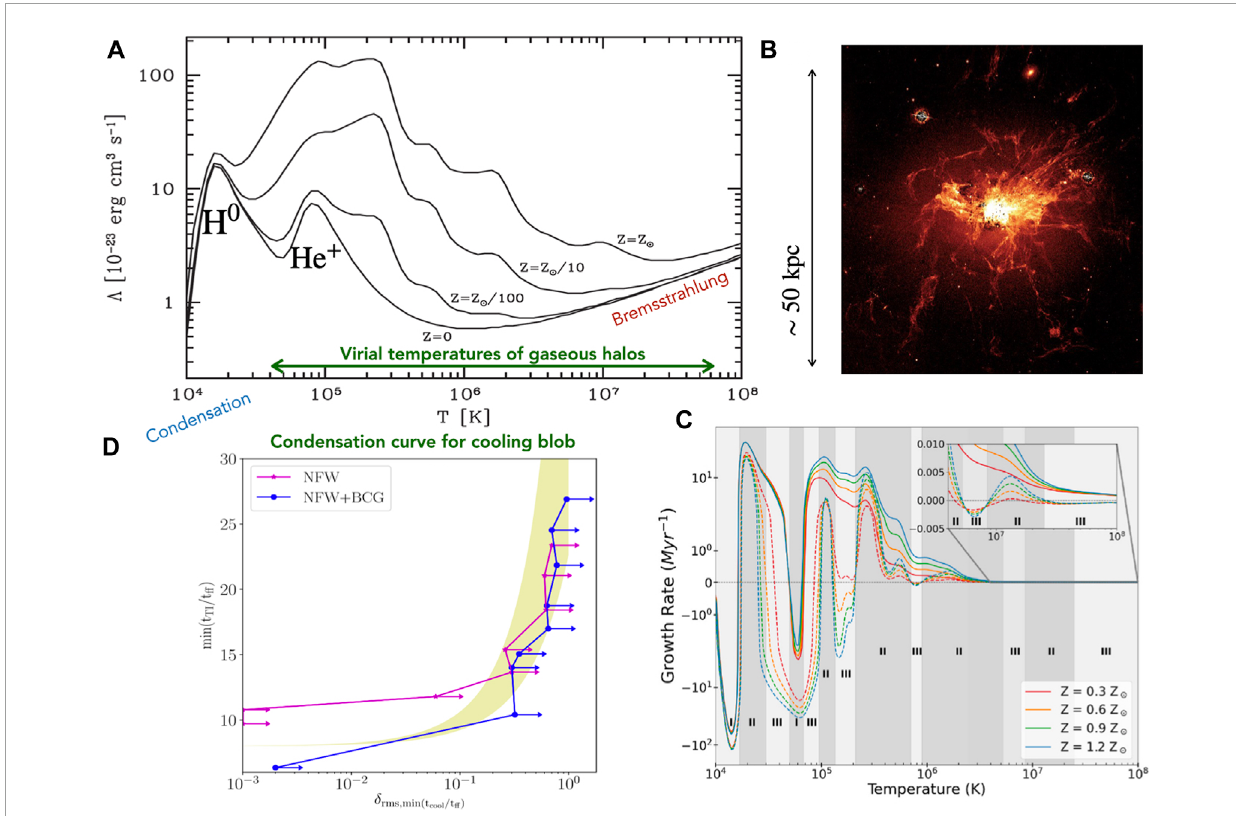
FIGURE 1 (A) Cooling function Λ( T ) as tabulated by Sutherland and Dopita (1993) for a gas in collisional equilibrium. The condensed gas is roughly around 10 4 K. (B) H α emission in red in NGC 1275 in the center of Perseus cluster (Figure 1 in Fabian et al., 2008) showing the filamentary structures, and the typical dimensions are 6 kpc in length and 70 pc in width. (C) Cooling function showing regimes of isobaric and isochoric stability/instability. (I) denotes the regime of stability for either modes, (II) denotes the regime of instability of either modes, and (III) denotes regime of isobaric instability and isochoric stability (see Das et al., 2021). (D) This parametric curve shows how local thermally unstable overdensity in a background of large t cool / t ff (hot gas at high entropy) can lead to condensation by maintaining a local moderate ratio t cool / t ff ∼ 8 (as marked by yellow using analytic estimate, Eq. 14 in Choudhury et al.,